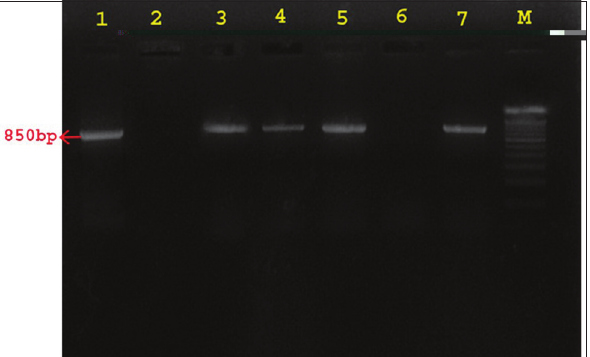
Figure-1: Agarose gel electrophoresis showing the results of PCR amplified product of 850 bp for the agrA gene of Staphylococcus pseudintermedius (SP) isolates. Lane 1, 3, 4, 5, 7: agrA gene positive for SP isolates; Lane 2 and 6: Staphylococcus aureus isolates negative for agrA gene of SP; Lane M: 100 bp DNA ladder.